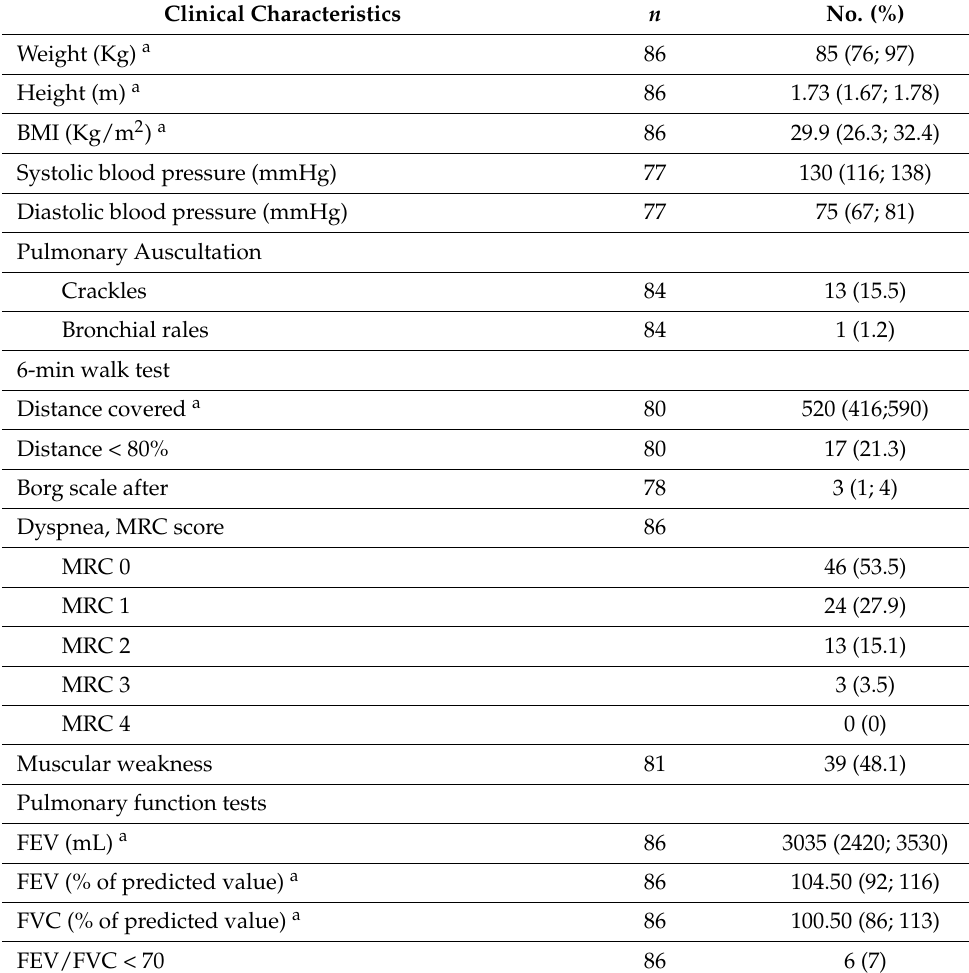
Table 2. Results of the REHCOVER